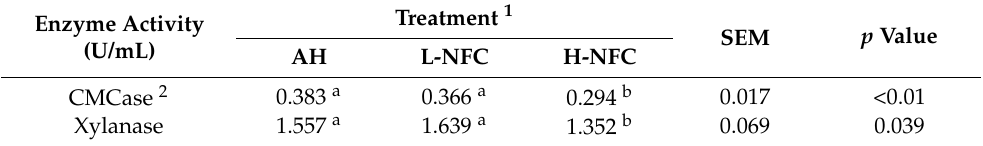
Table 2. Enzyme activity of rumen microorganisms exposed to three different diets. Enzyme